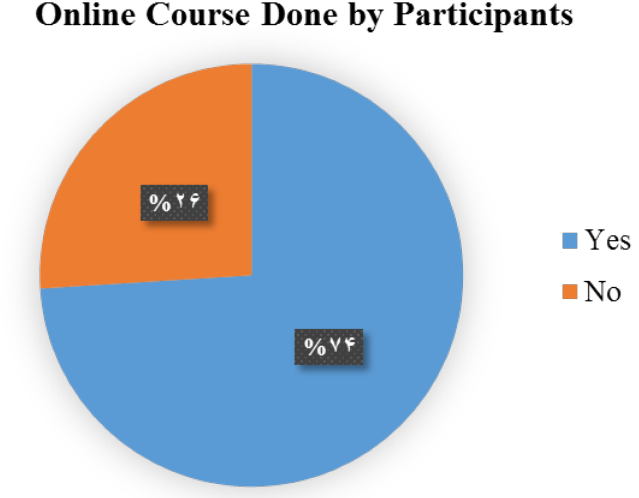
Figure - 15: Showing online course done by